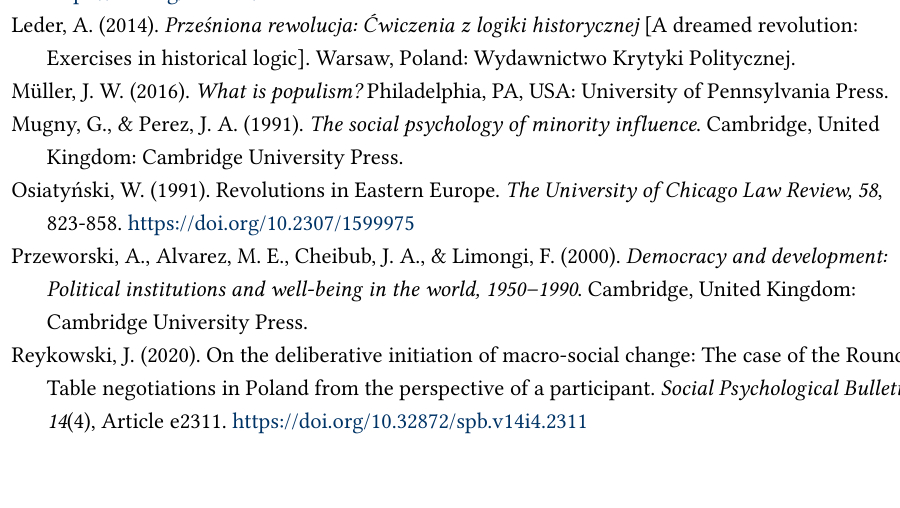
Table negotiations in Poland from the perspective of a participant. Social Psychological Bulletin, 14 (4), Article e2311.